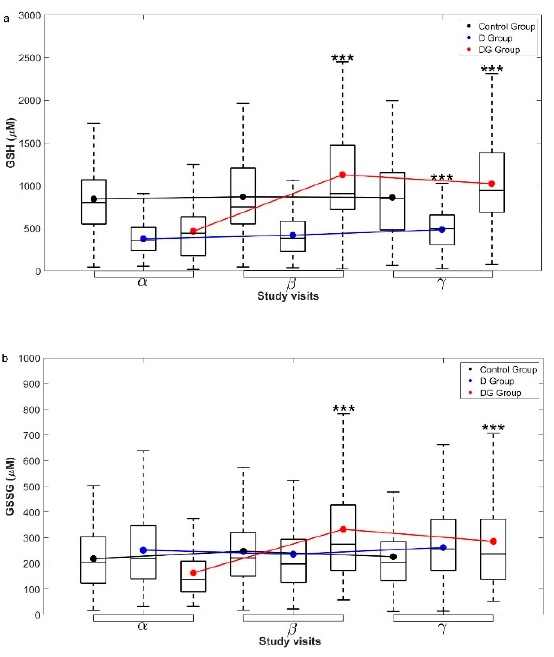
Figure 3. Longitudinal changes in the concentration of (a) GSH and (b) GSSG in different groups. The measured data for ( a ) GSH and ( b ) GSSG concentrations from Control, D, and DG groups at α , β , and γ visits are shown here with box and whiskers plots. Mean (black circles for Control, blue for D, and red for DG groups, respectively) and inter ‐ quartile ranges (IQR) of the data are overlaid over the corresponding box plots. The group ‐ wise means at different visits are connected using solid lines with the same color. Significance levels displayed above β , and γ visits denote the comparisons with α visit using permutation tests. Significance level is *** p < 0.001 for respective comparisons. Abbreviations used here are, GSH—reduced glutathione, and GSSG—oxidized glutathione.